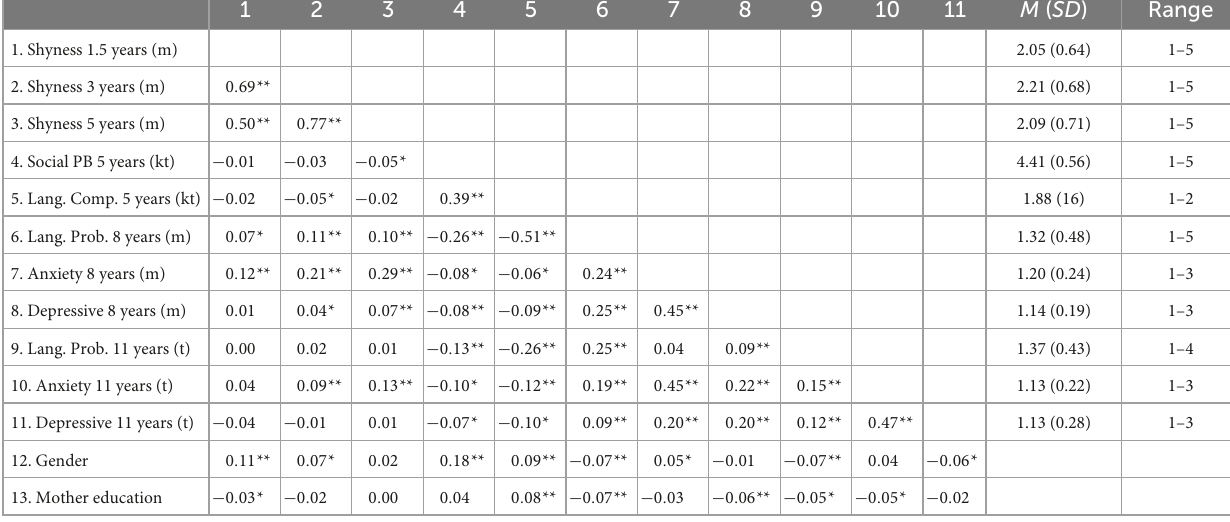
TABLE 1 Polychoric intercorrelations between study variables and descriptive statistics of